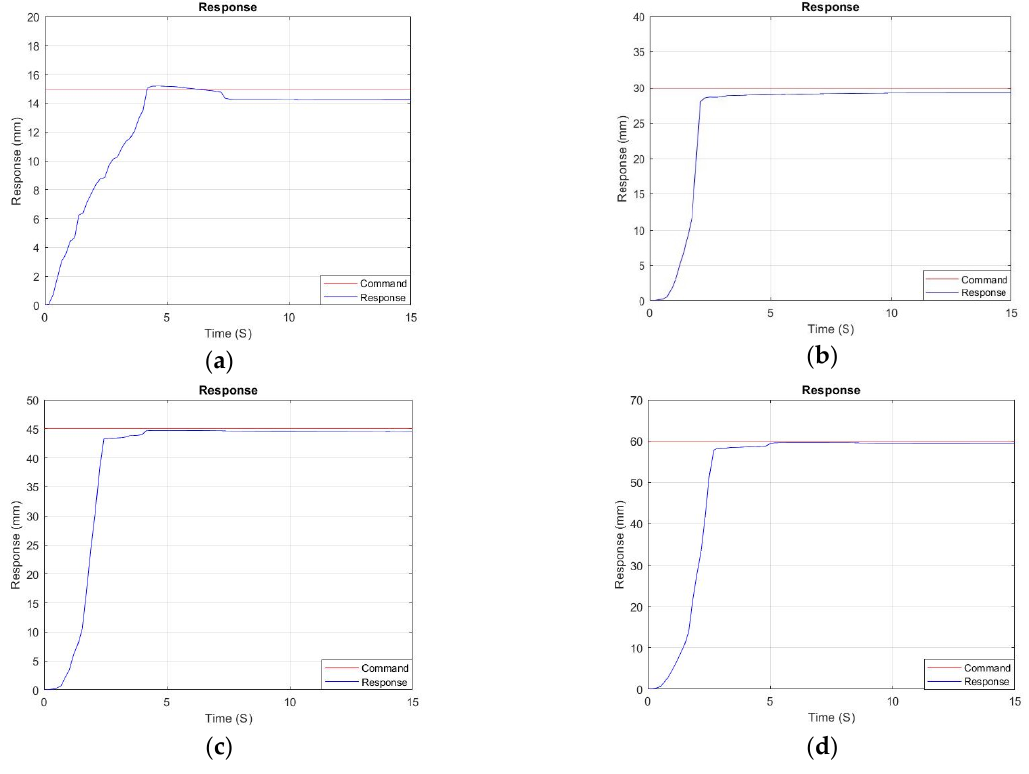
Figure 13. A closed-loop displacement control of ( a ) 15 mm, ( b ) 30 mm, ( c ) 45 mm, and ( d ) 60-step command signal. command Table 3. Step response characteristics for the NiTiNOL spring’s displacement.